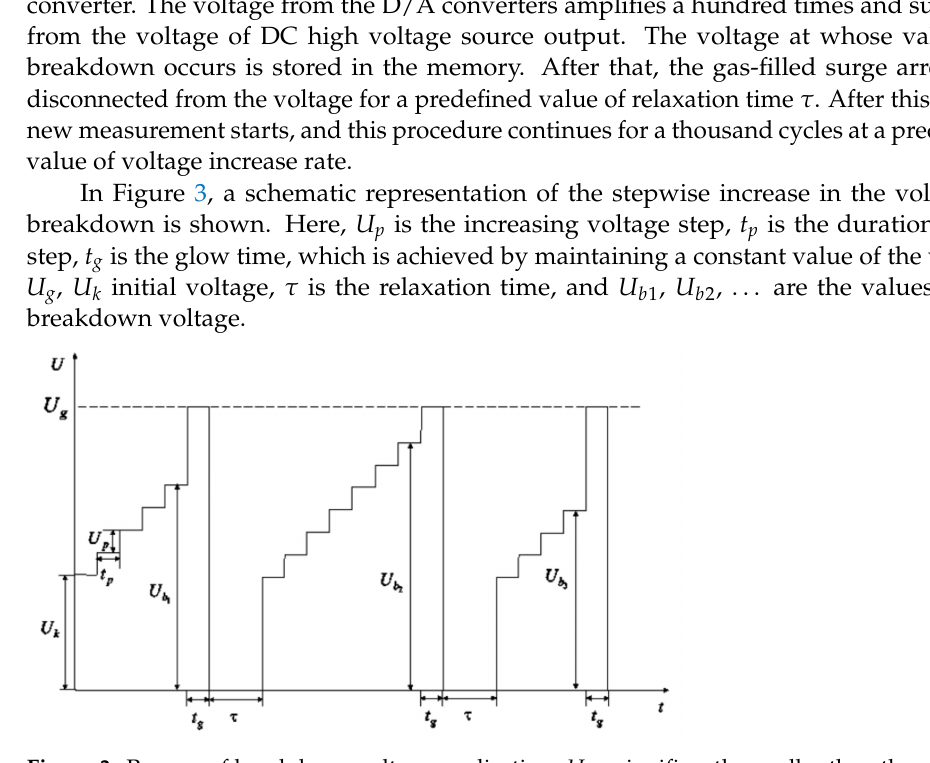
Figure 3. Process of breakdown voltage application: U k —significantly smaller than the expected breakdown; U g —value to which the voltage